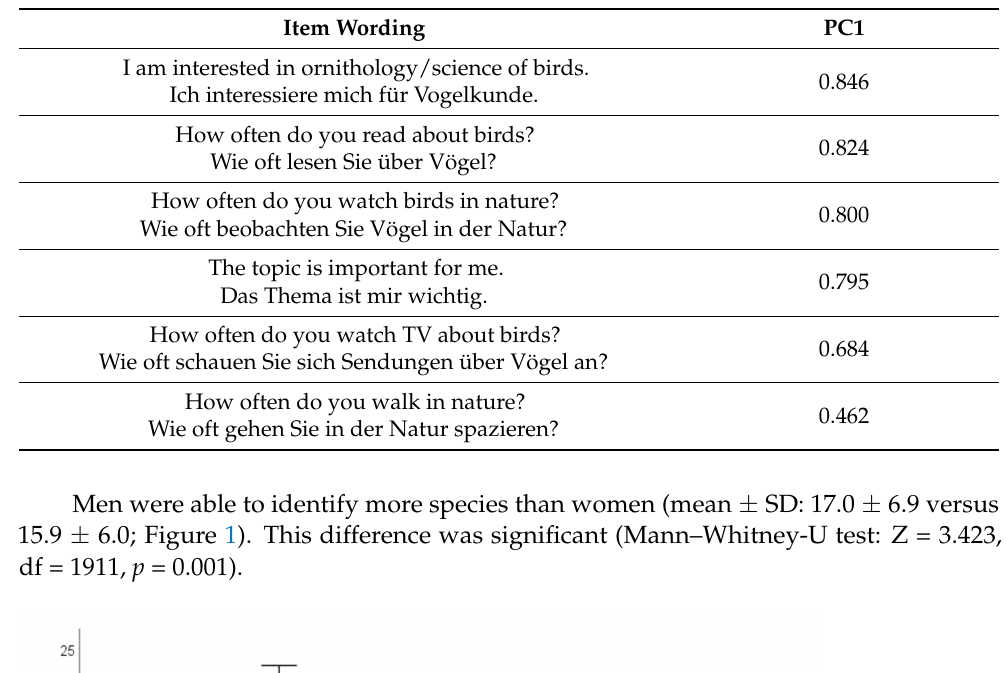
Table 3. Results of the explorative factor analysis. Loadings of the respective items on the principal component 1 (PC1) are shown in descending order. We show the original German items and the English version.